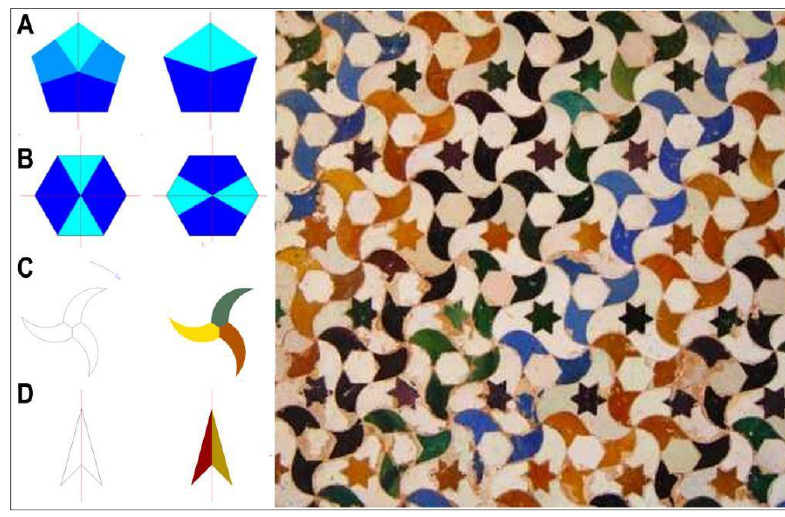
Figure 3. On the left some examples of geometric patterns, represented in b/w line and coloured: instinctively it is difficult to identify the same symmetries of the b/w pictures and the trend will be the interpretation of the colour as a decisive factor, by reducing from one side the symmetries number (the one of reflection and the other of rotation for the pentagon ( A )—identity—and two of reflection and two of rotation for the hexagon ( B )). This operation fixes clear preferential alignments. Doing that, it is possible even to inhibit rotation. In fact, in figure ( C ), if also the colour is taken into account, the picture in the right logically has no symmetry. So, an element with a single clear symmetry may be in the condition of losing it through the use of the colour. Similarly, the picture of figure ( D ) on the right side is not symmetric, except the identity, in the sense that the reflection one changes the colour position and only a double reflection leads to the initial state. On the right side a part of the Alhambra decoration.